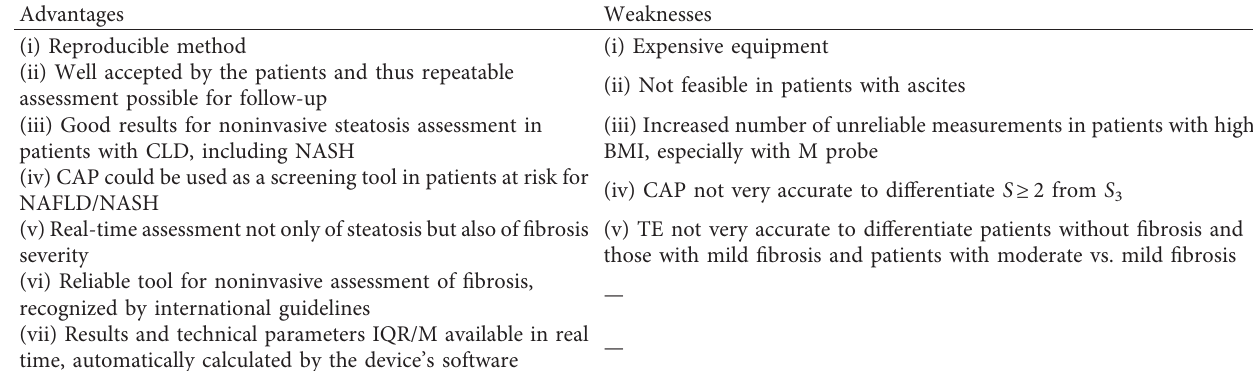
Table 2: Main advantages and weaknesses of